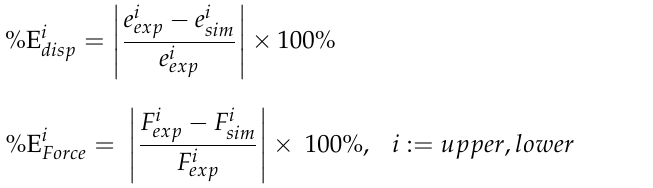
Table 4. The percentage relative errors of the resultant displacement (%E i